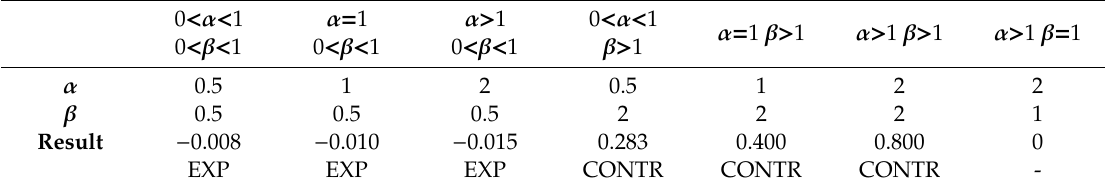
Table 4. Example of contractiveness according to the values of α and β . Source: Own elaboration. 0 < α <